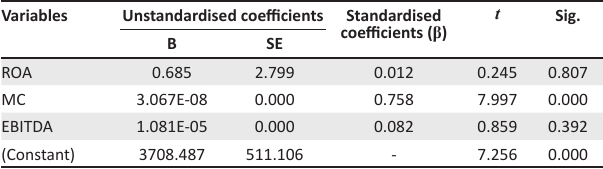
TABLE 7: Regression coefficients – Short-term incentive.